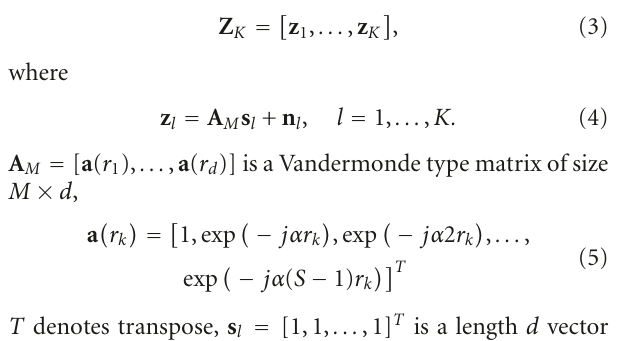
√ R = 2 · N subimage , where N antenna